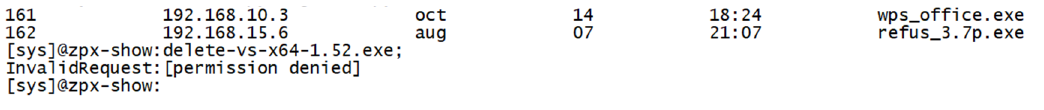
Figure 12. Wrong query.